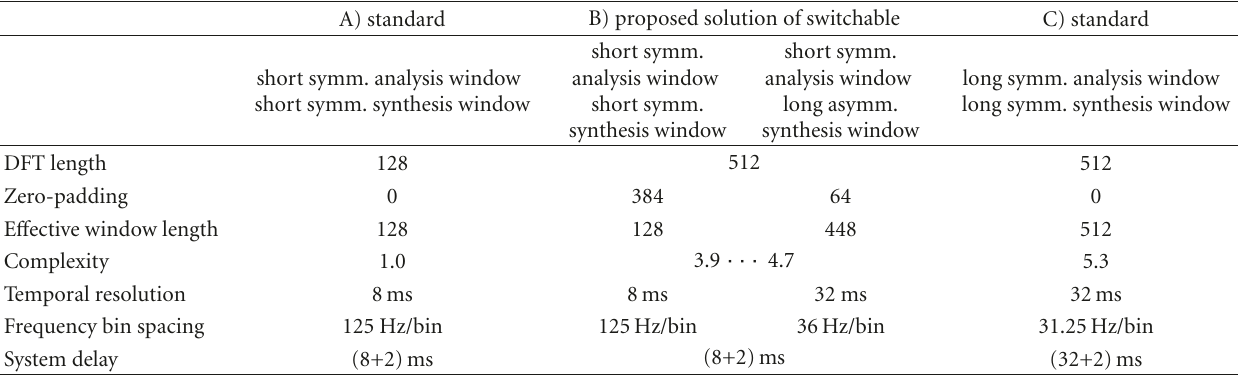
Table 1: Comparison of proposed window set (center column) with a standard analysis-synthesis system using short (left column) or long (right column) standard analysis and synthesis windows. The values are indicated for a sampling frequency f s = 16 kHz and a frame advance of R = 32 samples (2ms). The e ff ective complexity of the proposed solution varies between 3.9 and 4.7 depending on the rate of use of either the short or the long analysis window. Typically, the long analysis window will be used more frequently than the short analysis window.